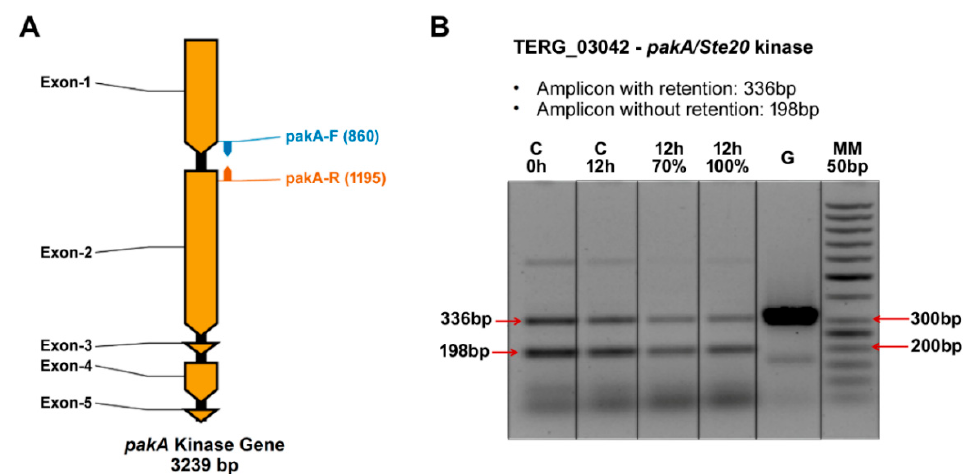
Figure 2. Intron retention analysis of the T. rubrum pakA / Ste20 kinase gene. ( A ) Graphical representation of the pakA / Ste20 kinase gene indicating its size (base pairs), five exons (dark yellow), four introns (black), and the primer-binding sites used for amplification of the region flanking intron 1 (blue and orange arrows); ( B ) Agarose gel electrophoresis (1.5%) run with qRT-PCR products from the pakA / Ste20 intron 1 region. C : culture without the presence of UDA; G : amplification from genomic DNA (gene amplification positive control); 0 h : amplification product from cDNA obtained from culture in medium lacking the drug; 70% : amplification product from cDNA obtained from culture in medium containing 70% of the UDA MIC; 100% : amplification product from cDNA obtained from culture in medium containing 100% of the UDA MIC; MM : molecular weight marker (50 bp).